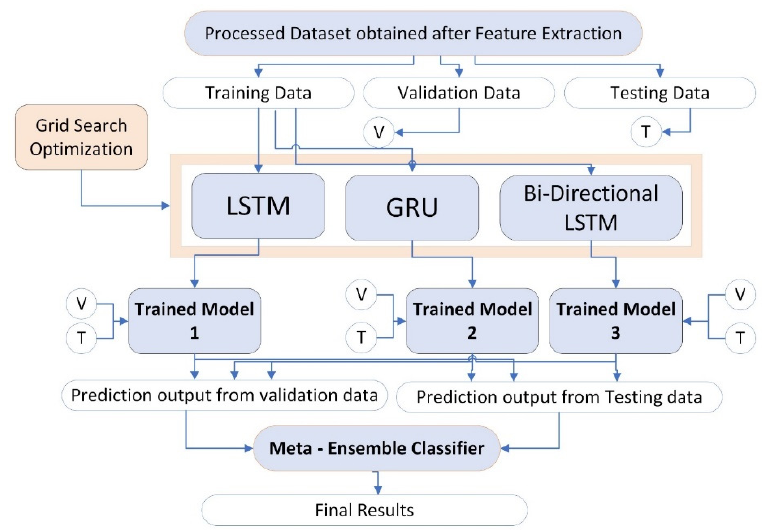
Figure 13. Proposed methodology of Ensemble Learning Model of LSTM, GRU, and bi-directional